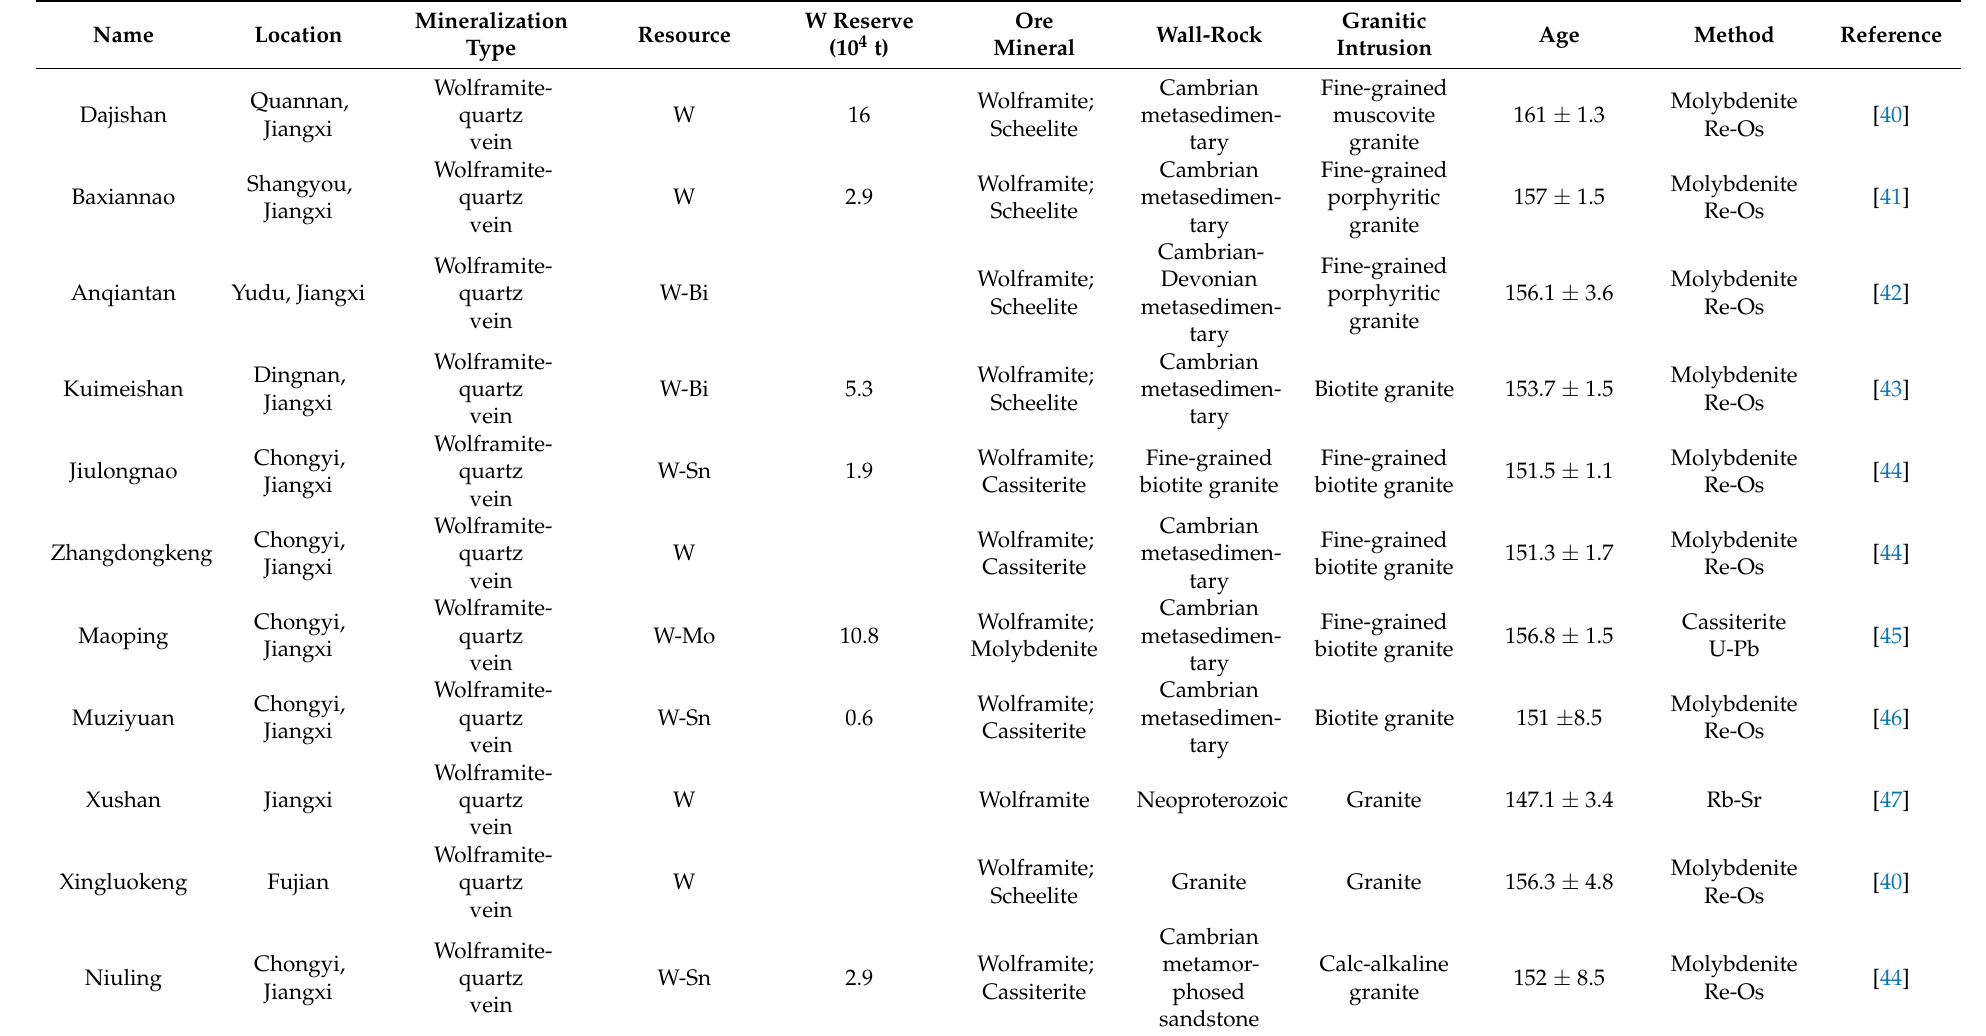
Table 1. Summary of the characteristics of wolframite quartz vein W deposits from all over the world, including chronological data and WO 3